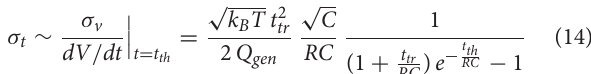
300K. The bashed black line on the left = 1ns. =